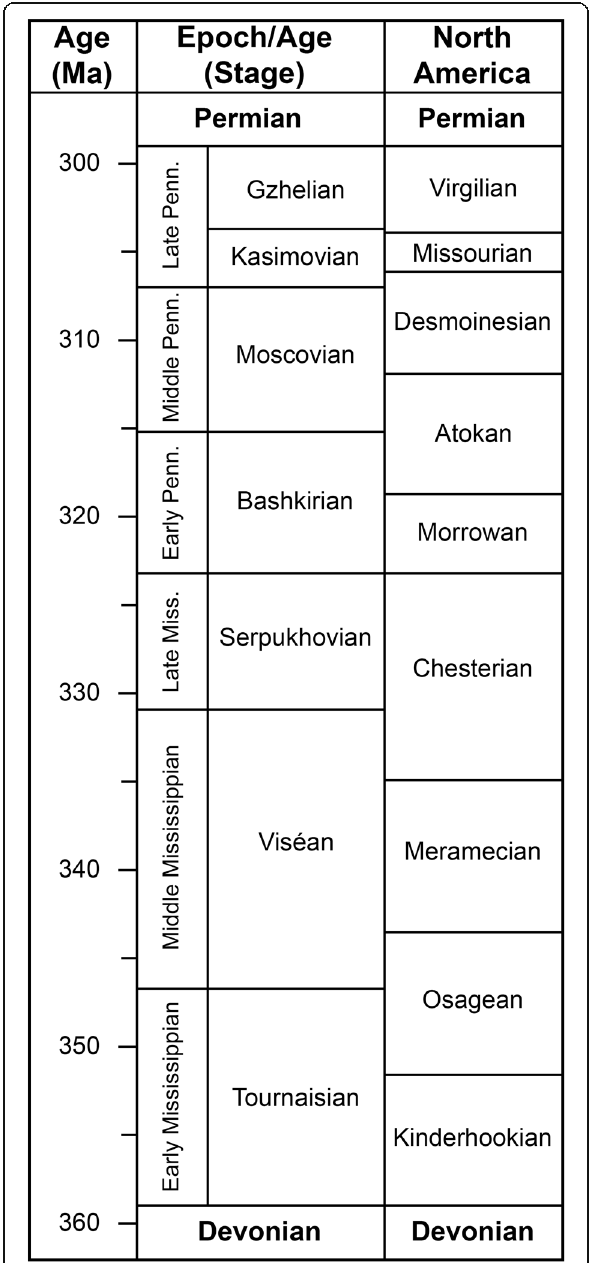
Fig. 1 Correlation of standard subdivisions of the Carboniferous Period with North American regional subdivisions. After ([15], fig.